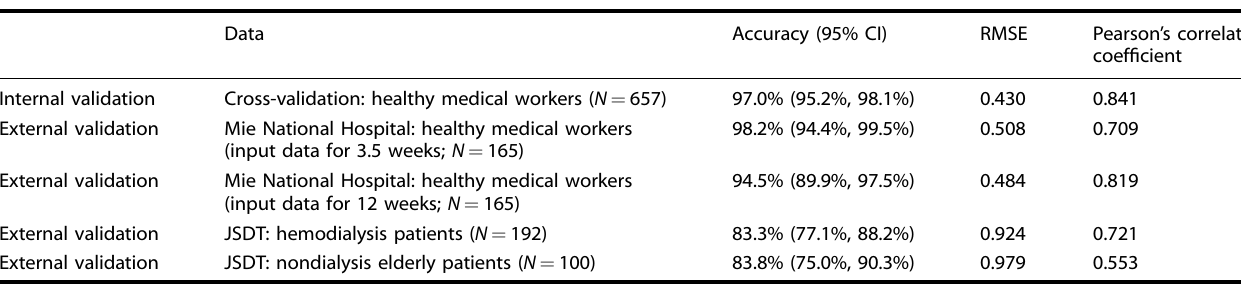
Table 2. Results of internal and external